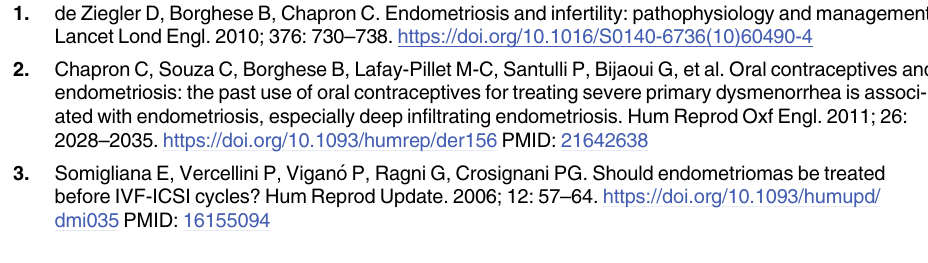
S1 Table. Baseline characteristics, COS, and ART outcomes in women exhibiting bilateral OMAs or an OMA with a diameter greater than 2